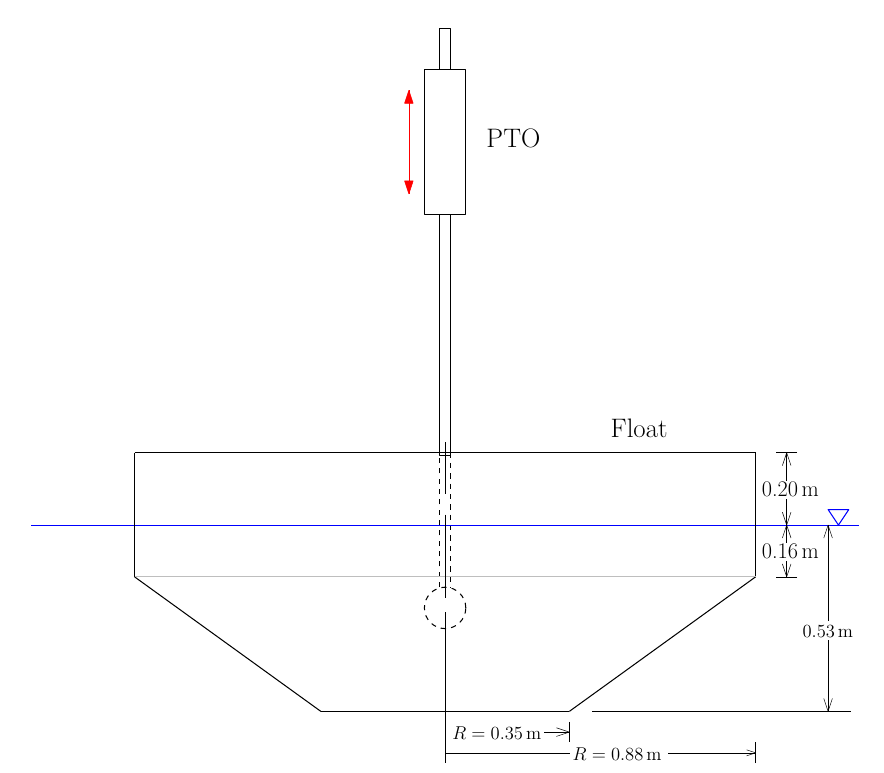
Figure 4. Test device diagram.